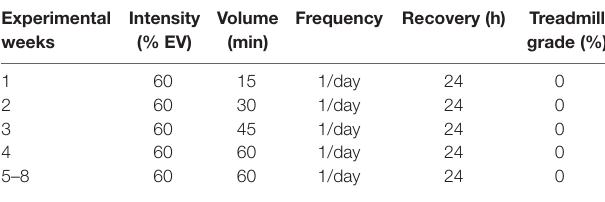
Table 1 | Characteristics of the training (TR) protocol.